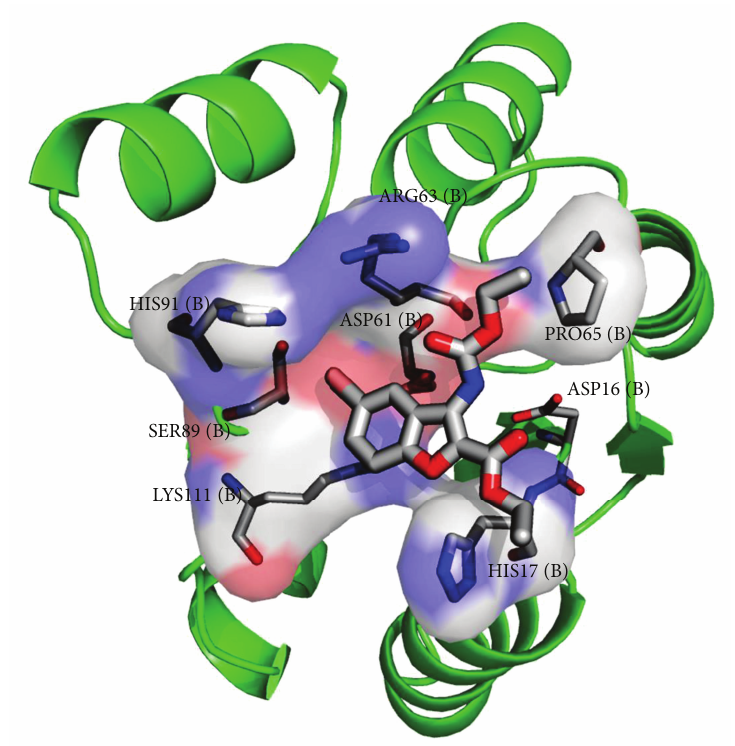
Figure 6: Interaction of C6 at the active site of